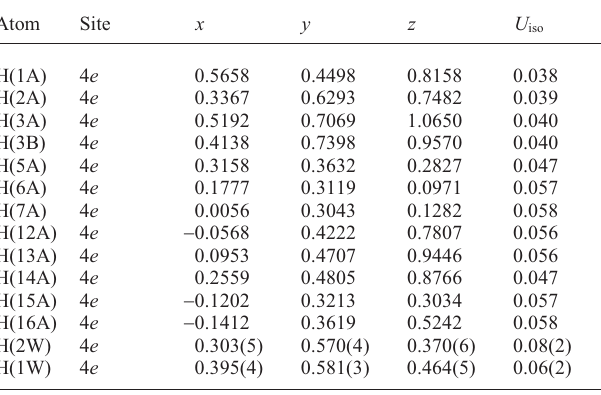
Table 2. Atomic coordinates and displacement parameters (in Å 2 )